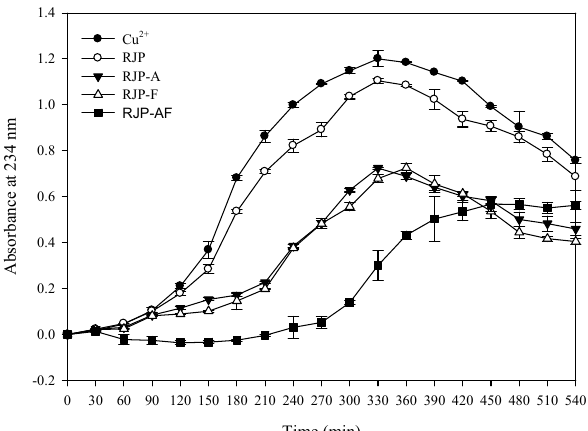
Figure 4. Effects of RJP and RJP hydrolysates on Cu 2+ mediated conjugated diene formation in low-density lipoprotein (LDL). low-density lipoprotein